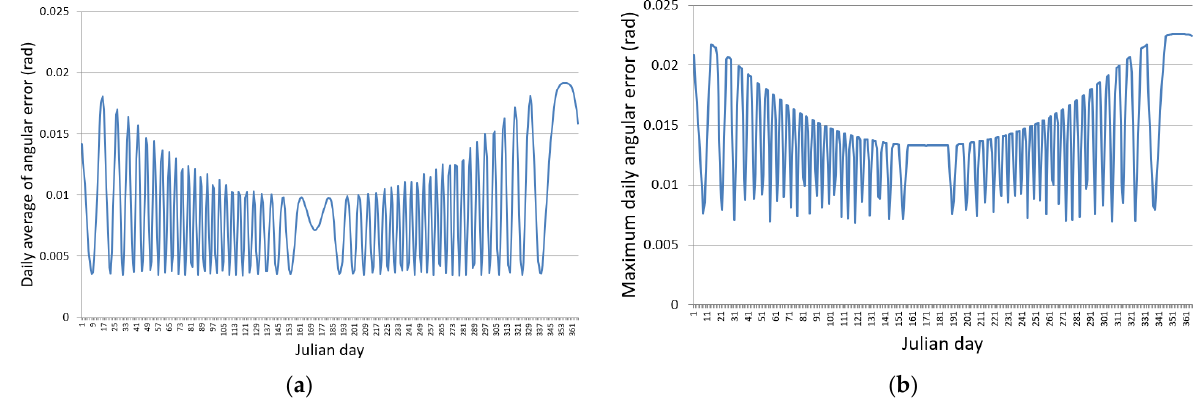
Figure 16. Representation of pointing error ξ vs. Julian day: ( a ) mean pointing error; ( b ) maximum pointing error.